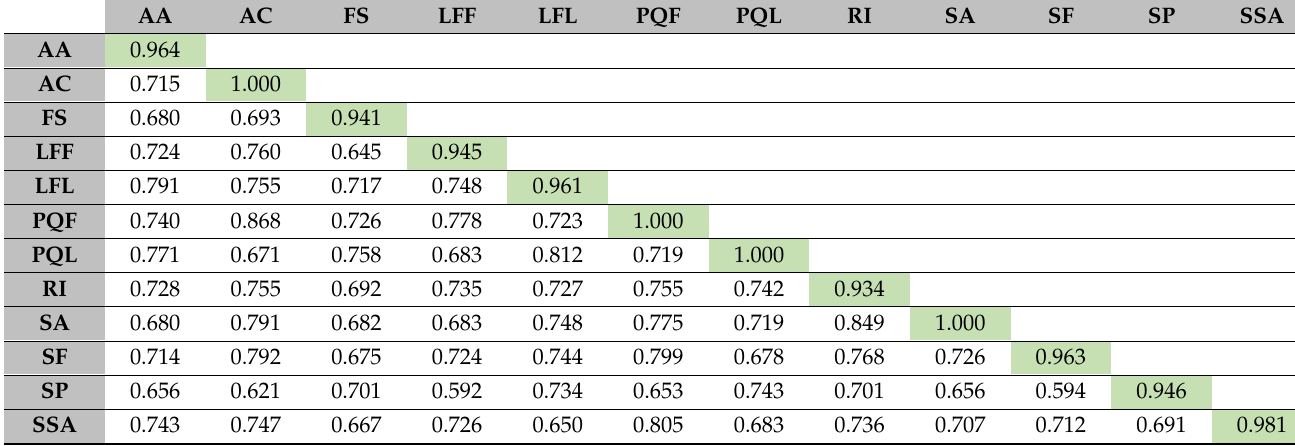
Table 3. Discriminant Validity Test Results (Fornell-Larcker criterion).